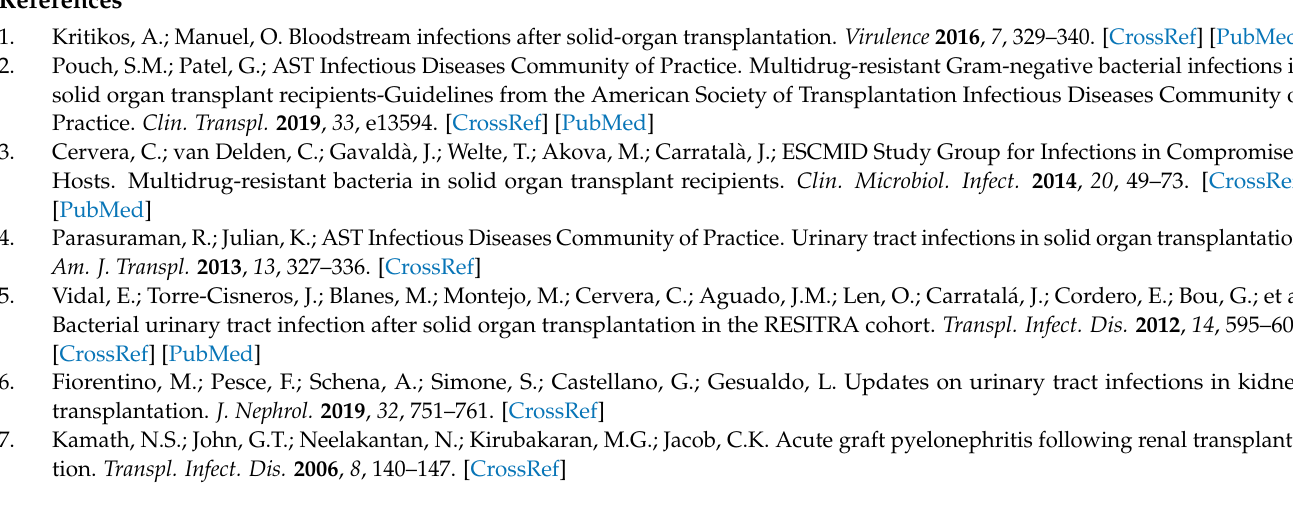
Table S2: Comparison of causative microorganisms of 278 episodes of acute graft pyelonephritis with bacteremia in 214 KT recipients according to